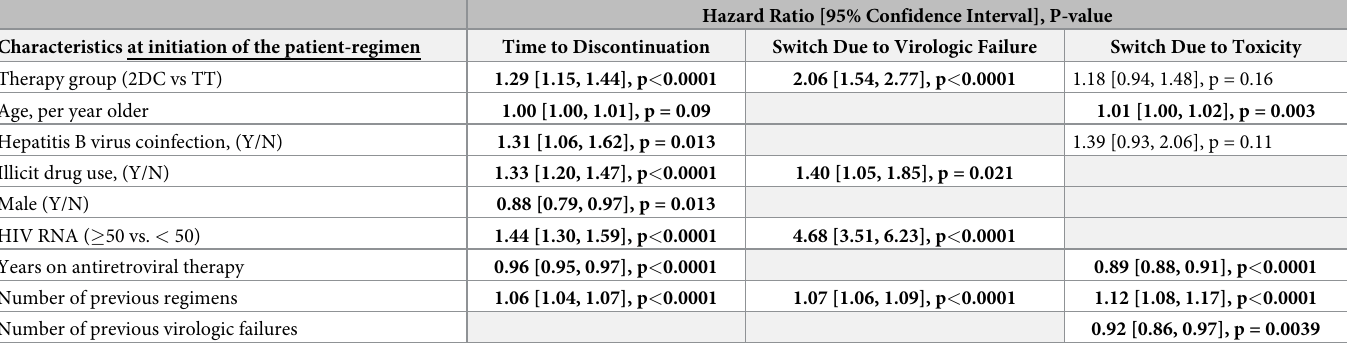
Hazard Ratio [95% Confidence Interval], P-value